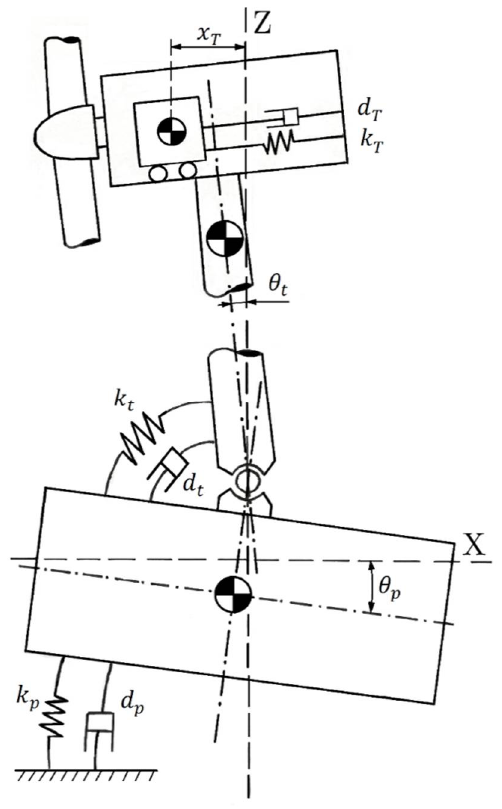
Figure 3. FOWT system with a fore-aft TMD in the